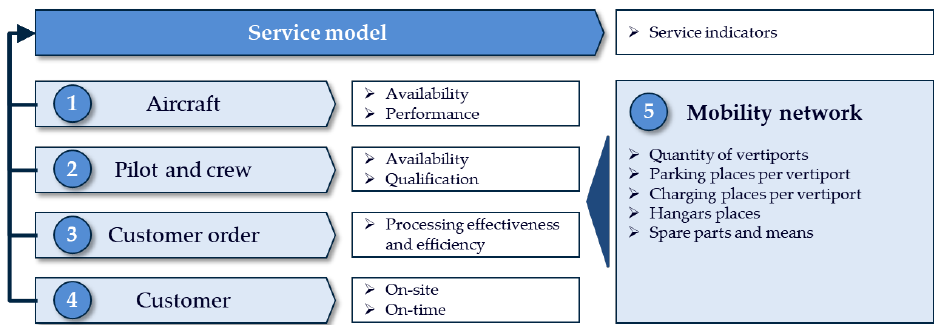
Figure 7. On-demand air mobility requests.